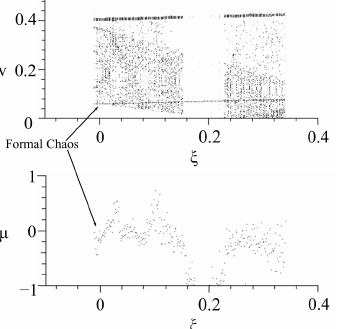
Figure 15. Bifurcation diagram with ξ parameter.